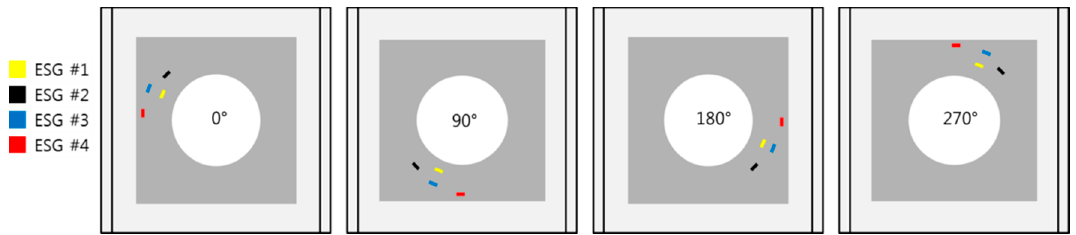
Figure 7. Four positions of the bearing plate installed in the fixing jig.